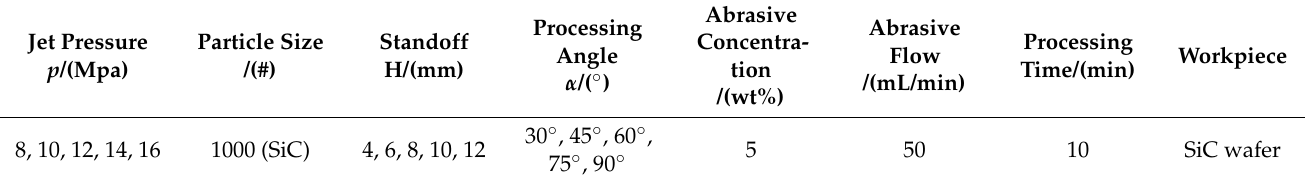
Table 3. Processing parameters of self-excited oscillating abrasive water